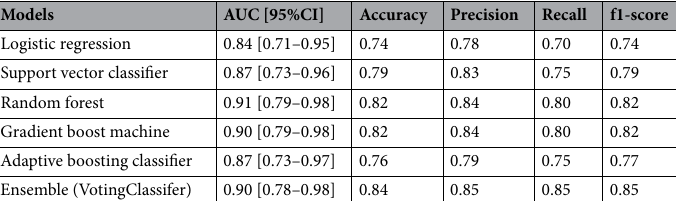
Table 2. Performance of the six ML models for the estimation of mortality of patients with a POCA. The 95% CI of AUC was calculated from 1000 bootstrap resamples of predictions on the test